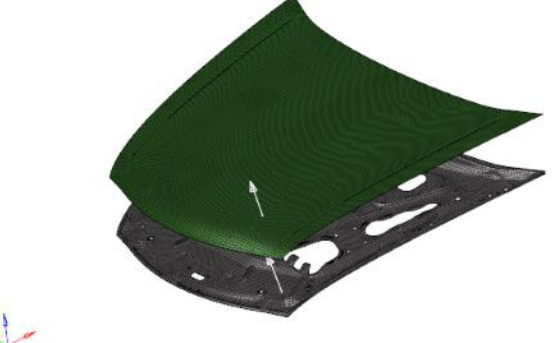
Figure 7. Model of CF/BF hybrid composites engine hood.